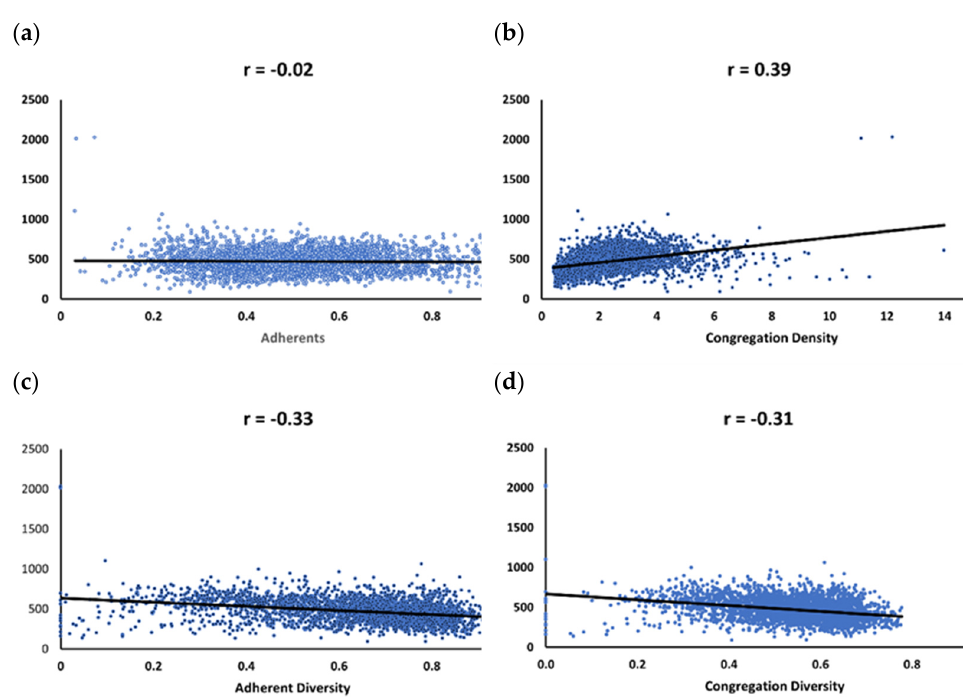
Figure 1. Mortality Correlations and Scatterplots. ( a ) Adherents; ( b ) Congregation Density; ( c ) Ad- herent Diversity; ( d ) Congregation Diversity.